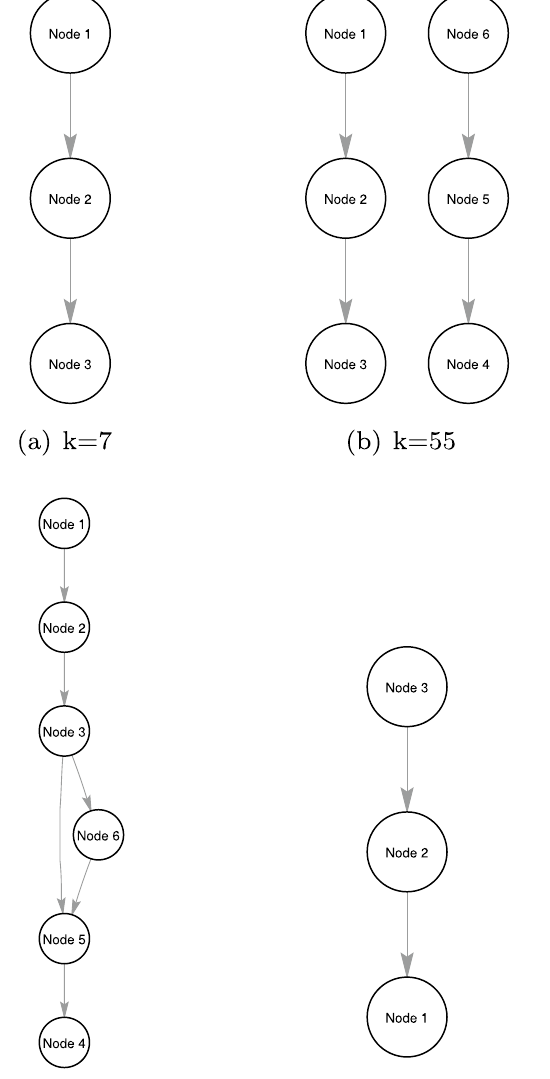
Fig. 17 Structure estimation of group targets